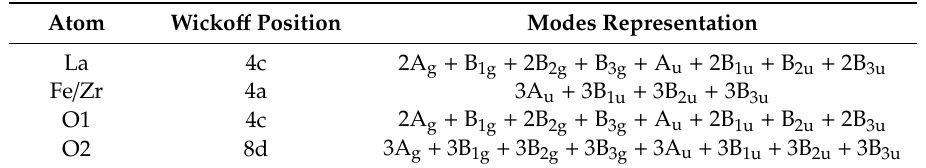
Table 2. Atoms, Wicko ff position, and modes representation of LaFe 1 − x Zr x O 3 (x = 0.01, 0.05) with Pbnm